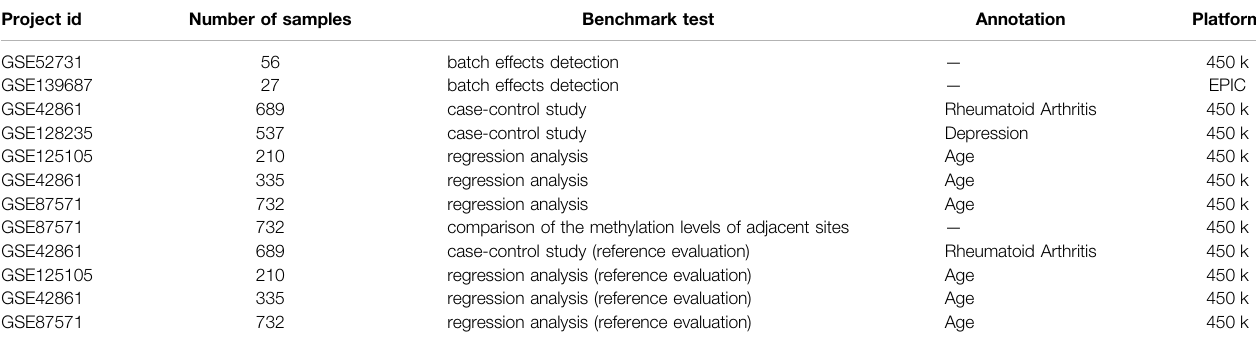
TABLE 1 | Overview of benchmark test